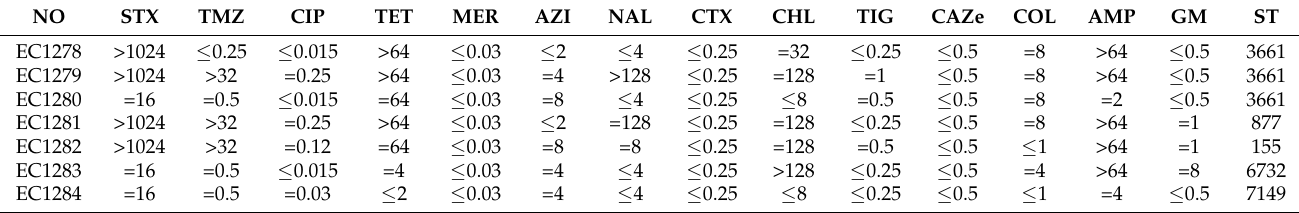
Table 1. The antimicrobial drug susceptibility and STs in seven mcr-1 -positive